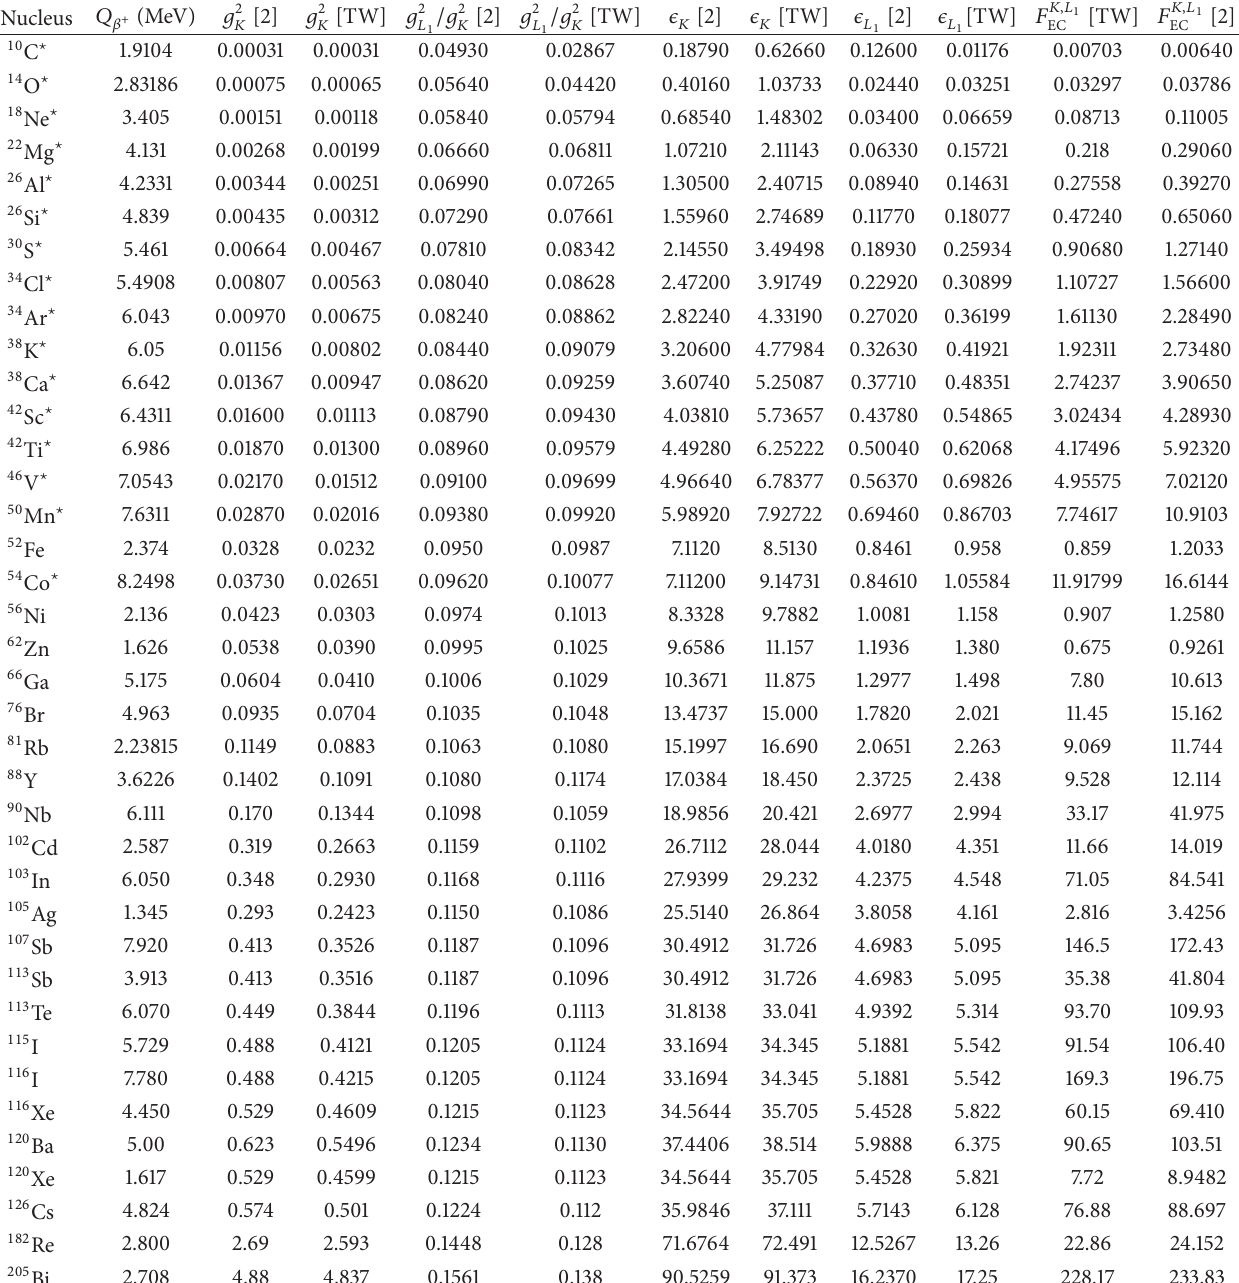
Table 3: Calculated phase space factors 𝐹 EC for electron capture (assuming exchange corrections to be equal to 1). The value of maximum 𝛽 -decay energy is taken from [15] for pure Fermi transitions. The electron densities, their ratios, and binding energies 𝜖 are also provided for orbitals 1𝑠 1/2 and 2𝑠 1/2 , including those given in [2]. Binding energies are given in units of